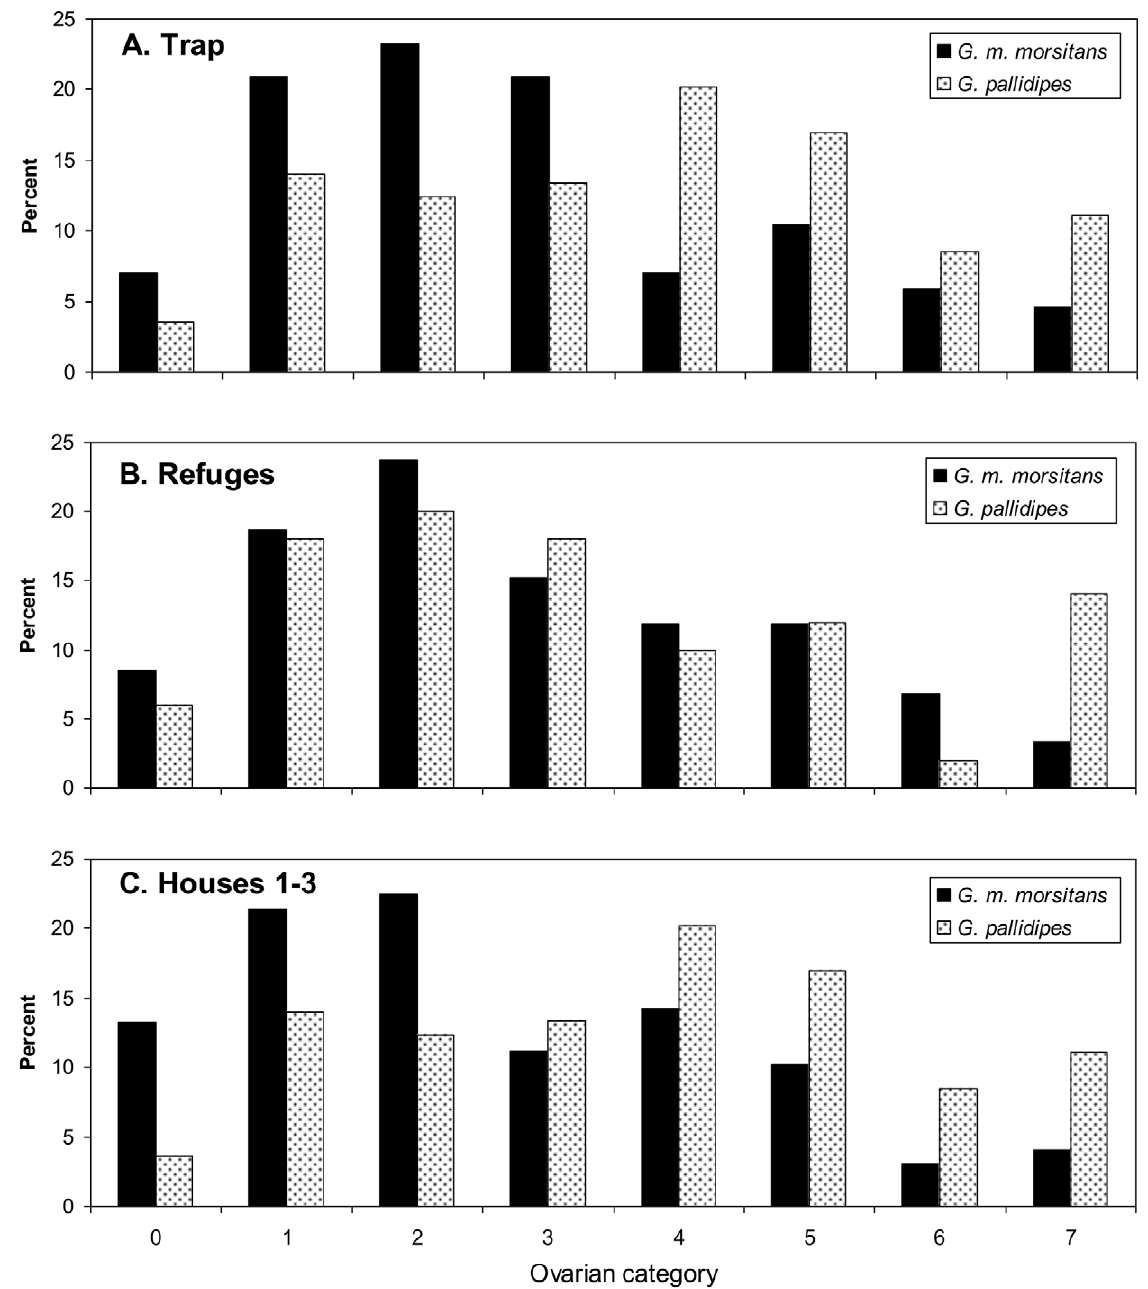
Figure 5. Percent distribution of ovarian categories of catches at the trap (A), refuges (B) and Houses 1–3 (C). Based on pooled data for all months. Sample sizes for the trap, refuges and houses were 86, 59 and 98, respectively, for G. m. morsitans and 627, 50 and 307, respectively, for G. pallidipes .